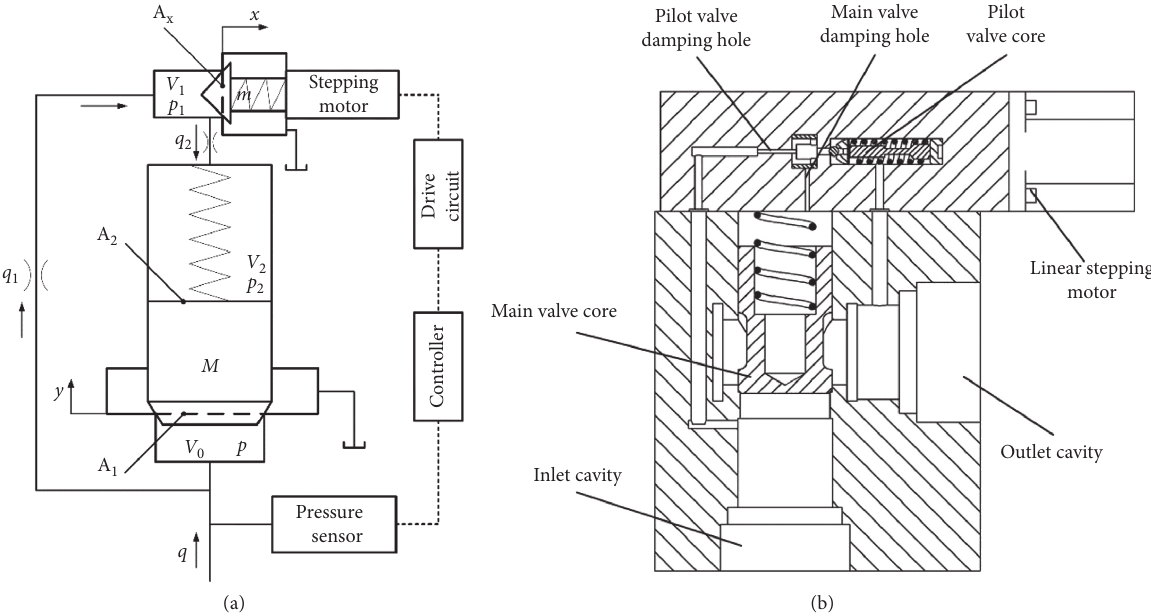
Figure 1: Structure and principle diagram of digital relief valve. (a) Principle control diagram. (b) Structure